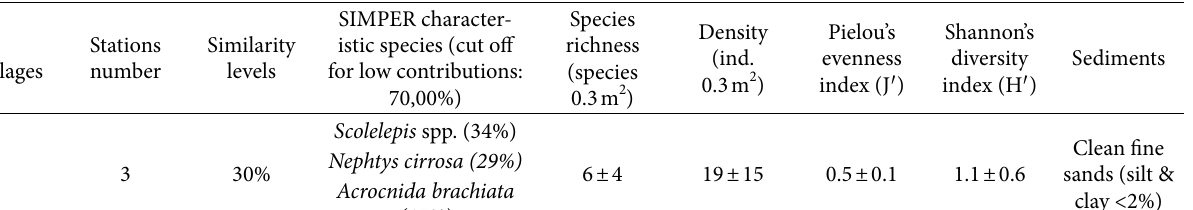
Table 4: Biotic characteristics of the three main groups of stations identified by cluster analysis along the French Basque coast during the field campaigns.